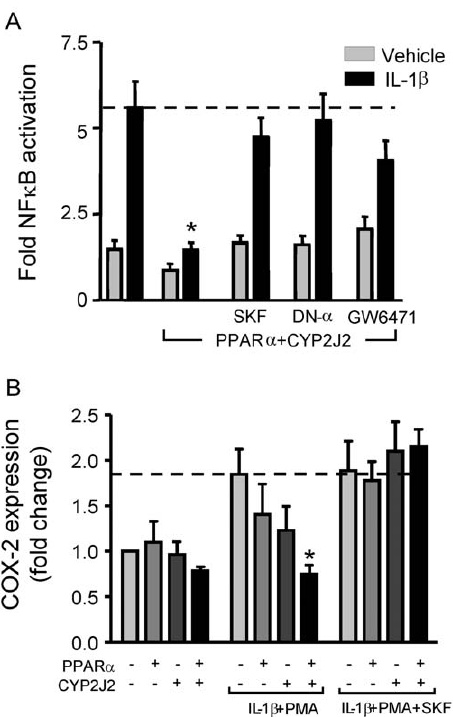
Figure 1. CYP2J2 has anti-inflammatory actions in vitro through the activation of PPAR a . (A) CYP2J2 and PPAR a co- transfection abolishes IL-1 b (10 ng/ml; 18 h) induced NF k B reporter gene activation. HEK293 cells were transfected with a NF k B-luciferase reporter gene and combinations of expression plasmids for CYP2J2 and PPAR a , or control empty plasmid (pcDNA3.1). The CYP2J2-PPAR a mediated inhibition of IL-1 b -induced NF k B activation is reversed by SKF525A (30 m M), co-transfection with dominant negative (DN)-PPAR a , or a selective PPAR a antagonist GW6471 (3 m M). *denotes p , 0.05 between IL-1 b and treatments, by one-way ANOVA and Bonferroni’s post test. Data represents mean 6 SEM of n=9 determinations from 3 separate experiments. (B) CYP2J2 and PPAR a co-transfection abolishes IL-1 b (10 ng/ml) and PMA (1 nM) induced COX-2 mRNA expression (24 h) determined by semi-quantitative RT-PCR. The abolishment of COX-2 mRNA is reversed when cells are co-incubated with the epoxygenase inhibitor SKF525A (30 m M). *denotes p , 0.05